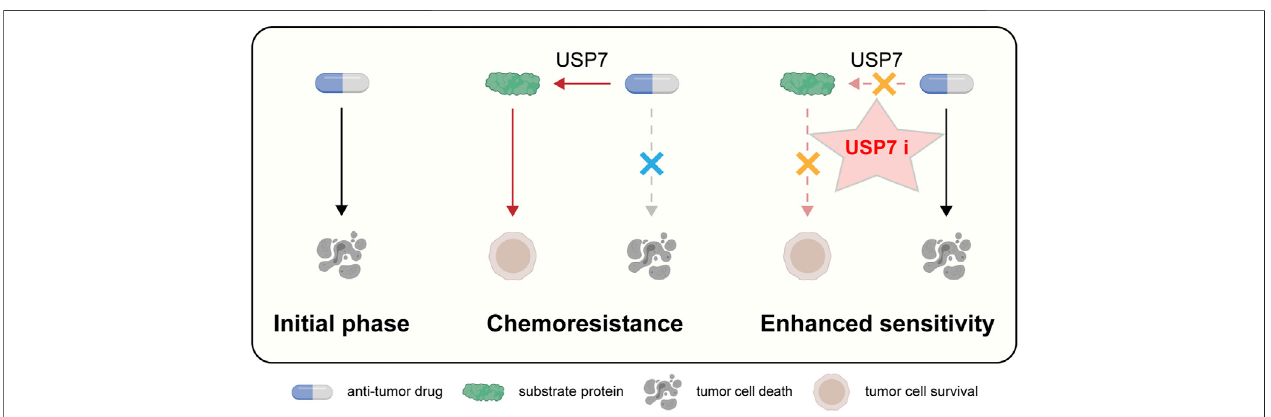
FIGURE 3 | Schematic representation of targeting USP7 to overcome resistance to anti-tumor therapies.